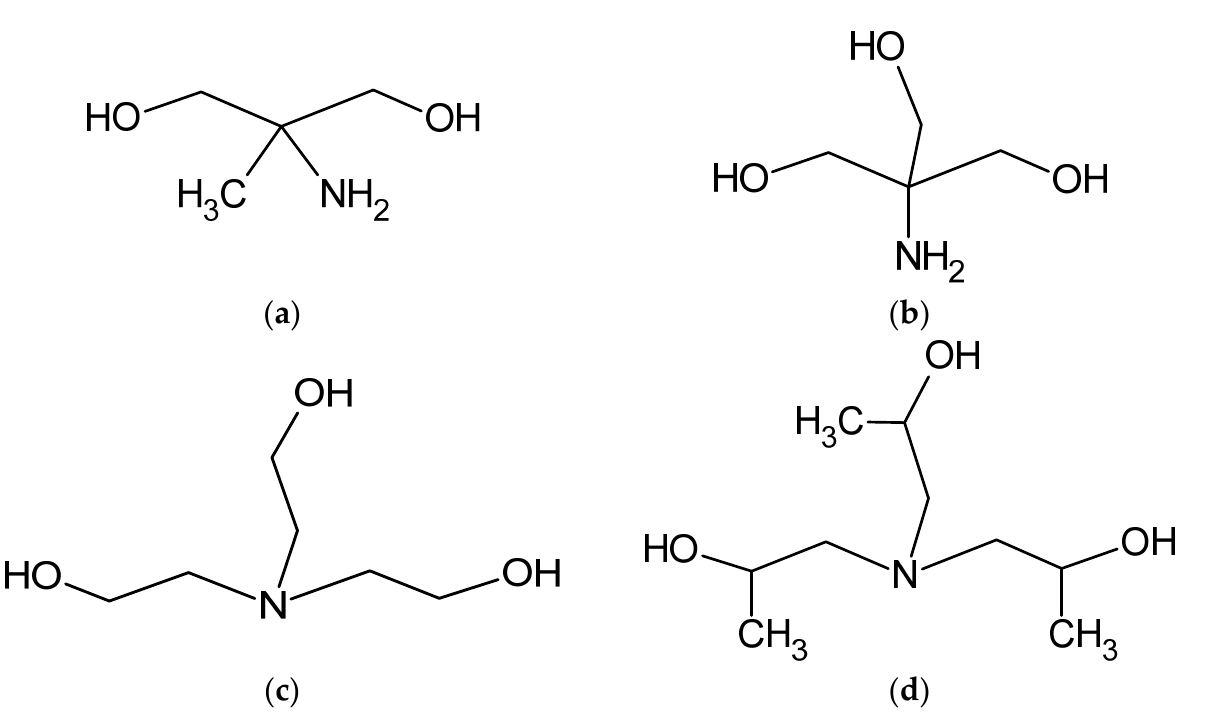
Figure 2. Schematic representation of the variability of the applied alcoholamine molecules: AMPD ( a ), TRIS ( b ), TEOA ( c ), and TIPA ( d ).